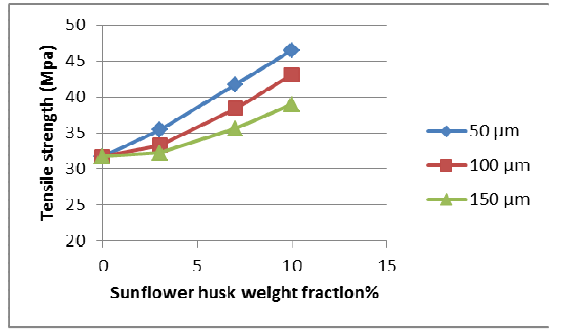
Fig. 6. Effect of sunflower husk particles on tensile